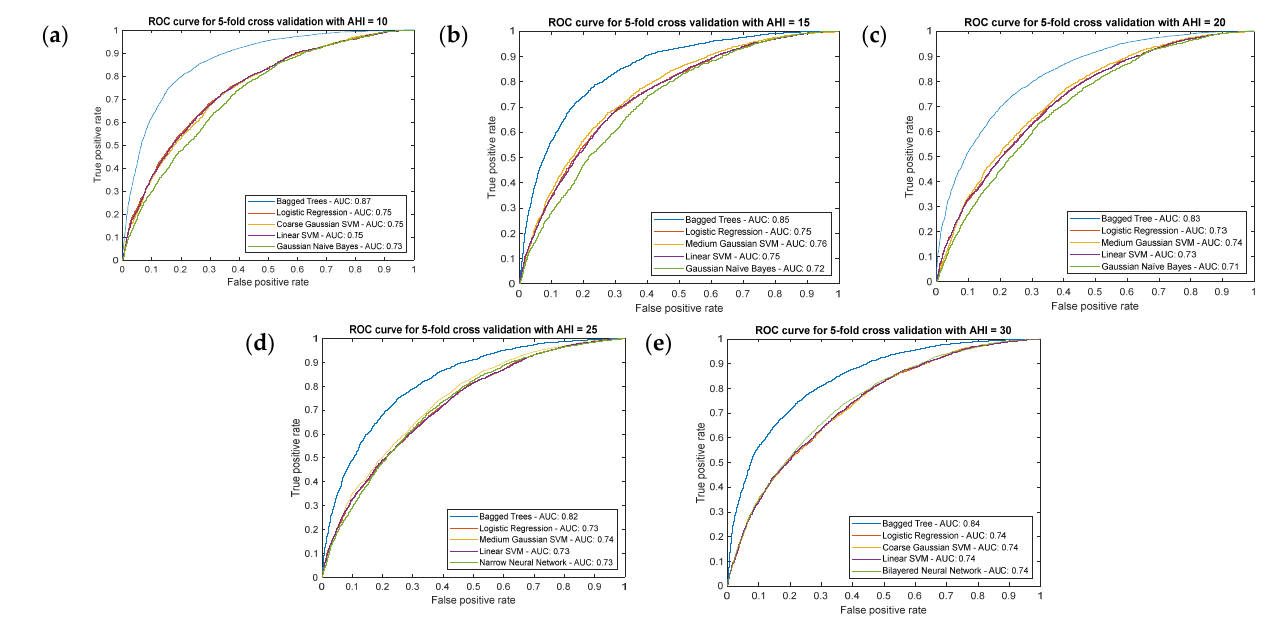
Figure 3. ROC curves for the different algorithms. ( a ) AHI threshold equal to 10; ( b ) AHI threshold equal to 15; ( c ) AHI threshold equal to 20; ( d ) AHI threshold equal to 25; ( e ) AHI threshold equal to 30.